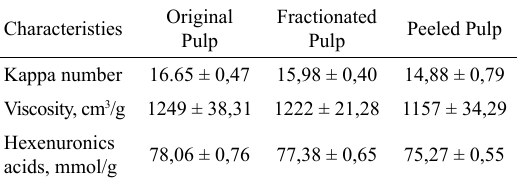
Table 2. Kappa number, viscosity and hexenuronic acids content in the treated and untreated unbleached pulps. Characteristies